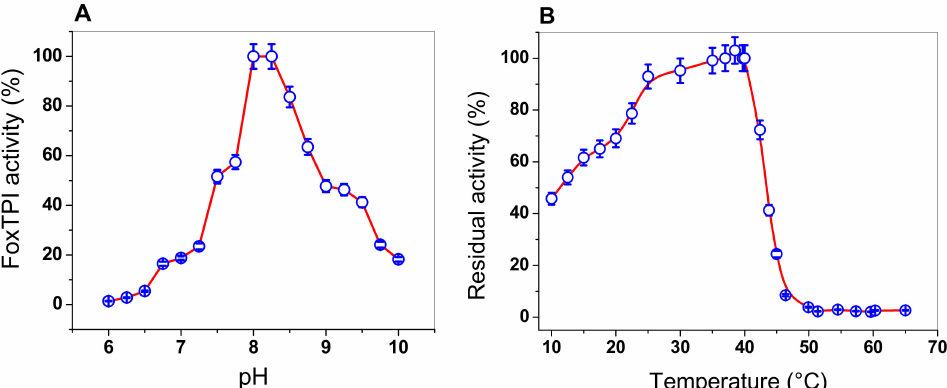
Figure 5. Determination of pH and temperature on the activity of FoxTPI. ( A ) e ff ect of pH on the activity of the FoxTPI protein. The activities were tested by measuring the specific activity under standard conditions at each pH value. The residual activity was tested by measuring the activity under standard conditions at each pH value. The bu ff ers used are described in Materials and Methods; ( B ) the e ff ect of temperature on the activity of FoxTPI protein. The protein was incubated at di ff erent temperatures (from 10 to 65 ◦ C) for 20 min in 50 mM Tris bu ff er at pH 8.0 and the residual activity was measured. In both assays, the data represent the mean ± SD from three independent measurements.